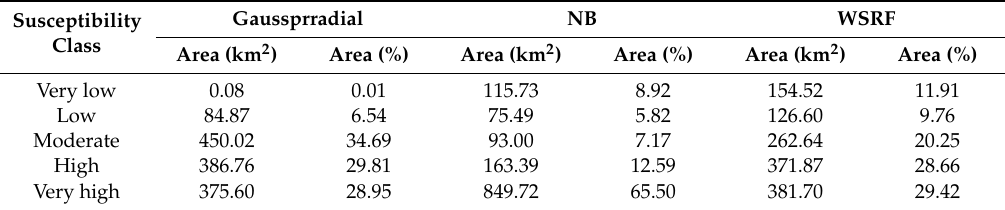
Table 4. Area of the susceptibility classes found using each